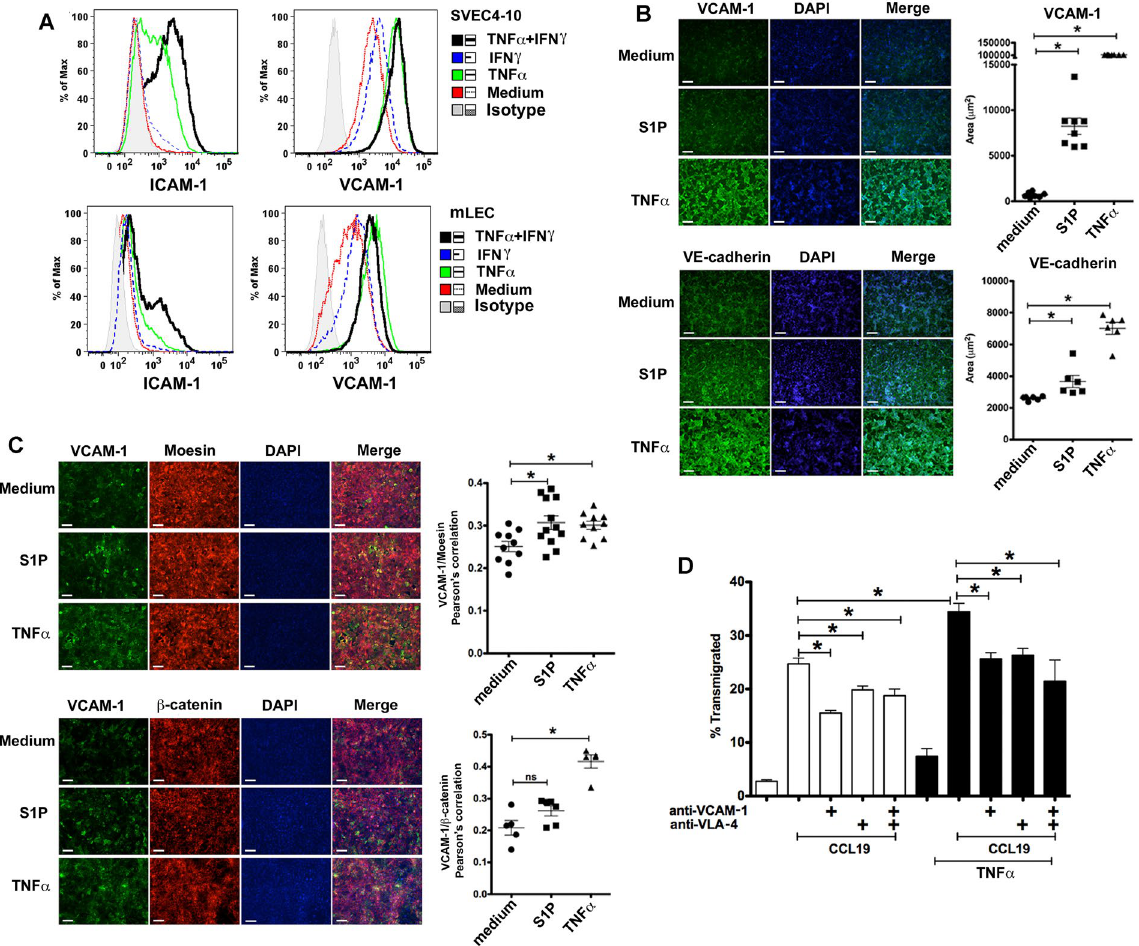
Figure 5. Adhesion molecule expression and CD4 T cell migration across SVEC4-10 layers treated with TNF α , IFN γ , or S1P. ( A ) SVEC4-10 or mLEC treated with TNF α and/or IFN γ , stained for VCAM-1 and ICAM-1, and analyzed with flow cytometry. ( B ) Fluorescent staining of SVEC4-10 treated with medium, TNF α or S1P for VCAM-1 and VE-cadherin (left) and quantitation of area labeled (right), x20, scale bar 42 μ m. ( C ) Fluorescent staining of SVEC4-10 layers treated with medium, TNF α or S1P for VCAM-1, moesin and β -catenin (left) and quantitation of label clustering (right), x20, scale bar 42 μ m. ( D ) CD4 T cell migration across iSVEC4-10 treated with TNF α , and blocked with anti-VLA-4 and/or anti-VCAM-1 mAbs. Representative of three independent experiments with triplicate wells in each assay * P <